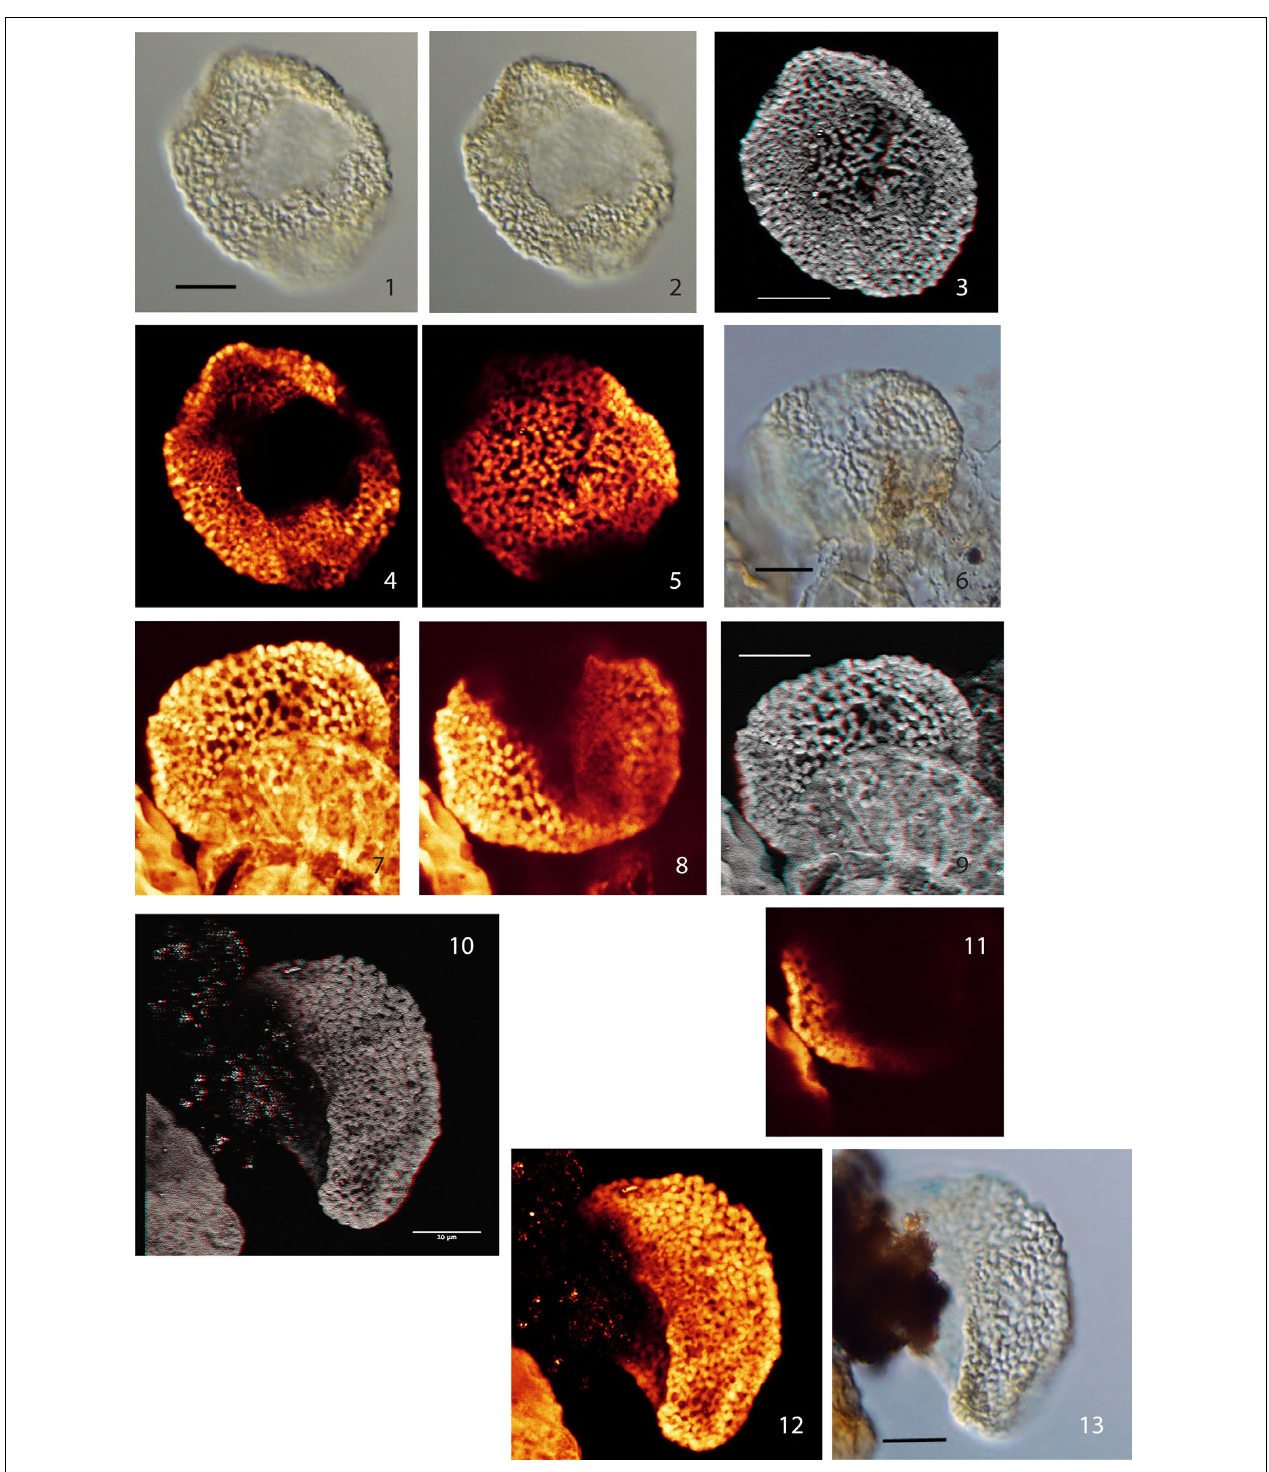
PLATE III | Scale bars: 10 µ m. (1), Pollen Type V, specimen A, LM image (median focus); (2) , Pollen Type V, specimen A, LM image (high focus); (3) Pollen Type V, specimen A, CLSM total stack image/projection, anaglyph; (4) Pollen Type V, specimen A, CLSM partial stack image, distal side (high focus); (5) Pollen Type V, specimen A, CLSM partial stack image, proximal side (low focus); (6) Pollen Type V, specimen B, LM image (high focus); (7) Pollen Type V, specimen B, CLSM total stack image/projection; (8) Pollen Type V,